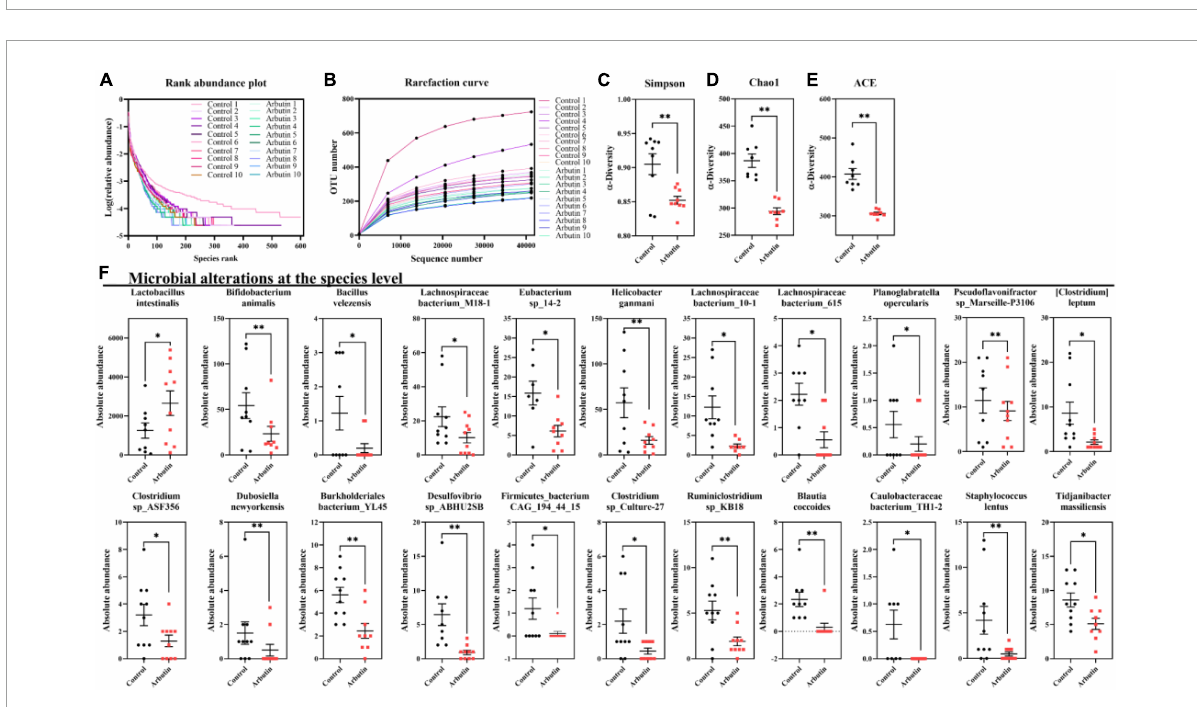
FIGURE4 Arbutin alters the gut microbiota. Rank abundance plot (A) , rarefaction curve (B) , Simpson index (C) , Chao1 (D) , ACE (E) , and species (F) were analyzed at 0.4 mg/ml. Differences were assessed by t -test and denoted as follows: ∗ P < 0.05, ∗∗ P <